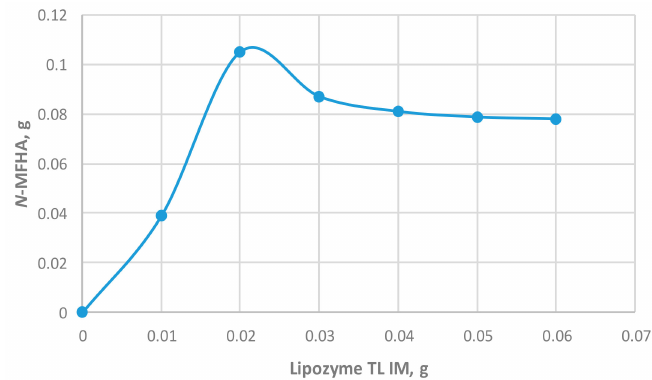
Figure 3. E ff ect of amount of enzyme: 2 g of oil, 10 mmol of N-methylhydroxylamine, 15 mL of hexane, and 25 h of incubation time.